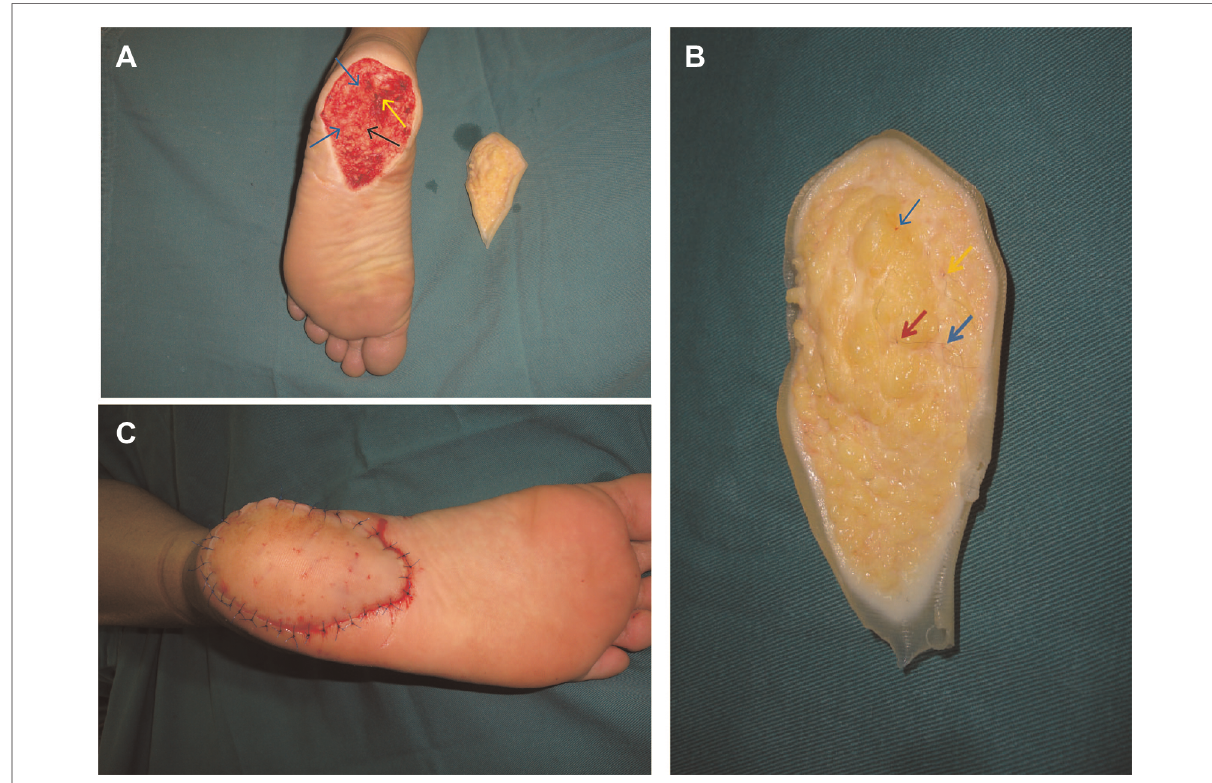
FIGURE 1 A 36-year-old male with a laceration to the left foot injury from broken porcelain shard. ( A ) Heel skin defect wound (7.5×6.0×0.8 cm), no bones and tendons exposed (Black arrows indicate arteries, yellow arrows indicate nerves, and blue arrows indicate veins). ( B ) The blood vessels and nerves are marked with 11-0 nylon under the microscope. (Red arrows indicate arteries, yellow arrows indicate nerves, and blue arrows indicate veins). ( C ) The replanted tissue immediately appeared healthy, following the